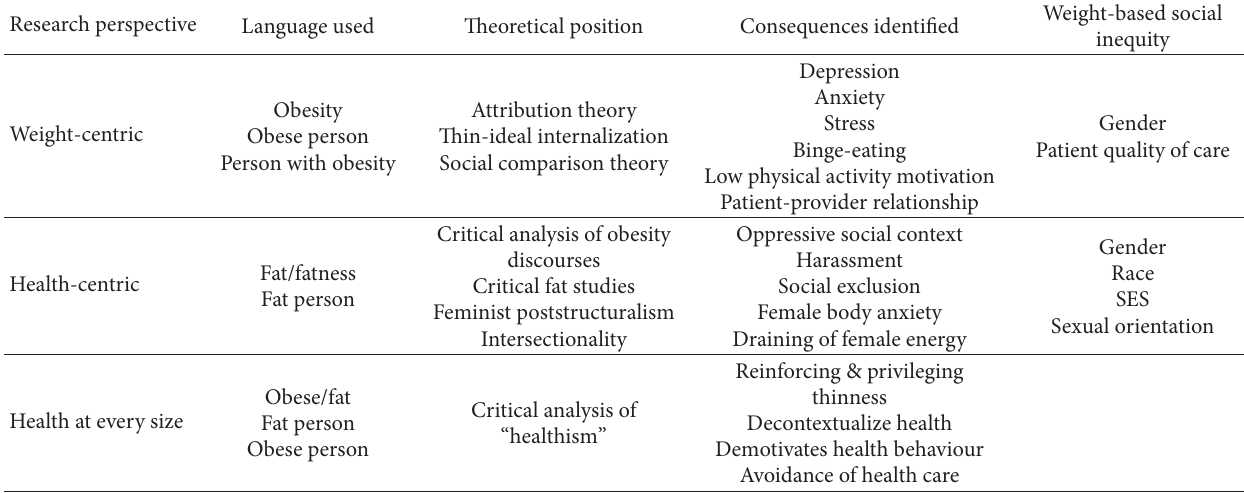
Table 1: Summary of similarities and differences identified among research